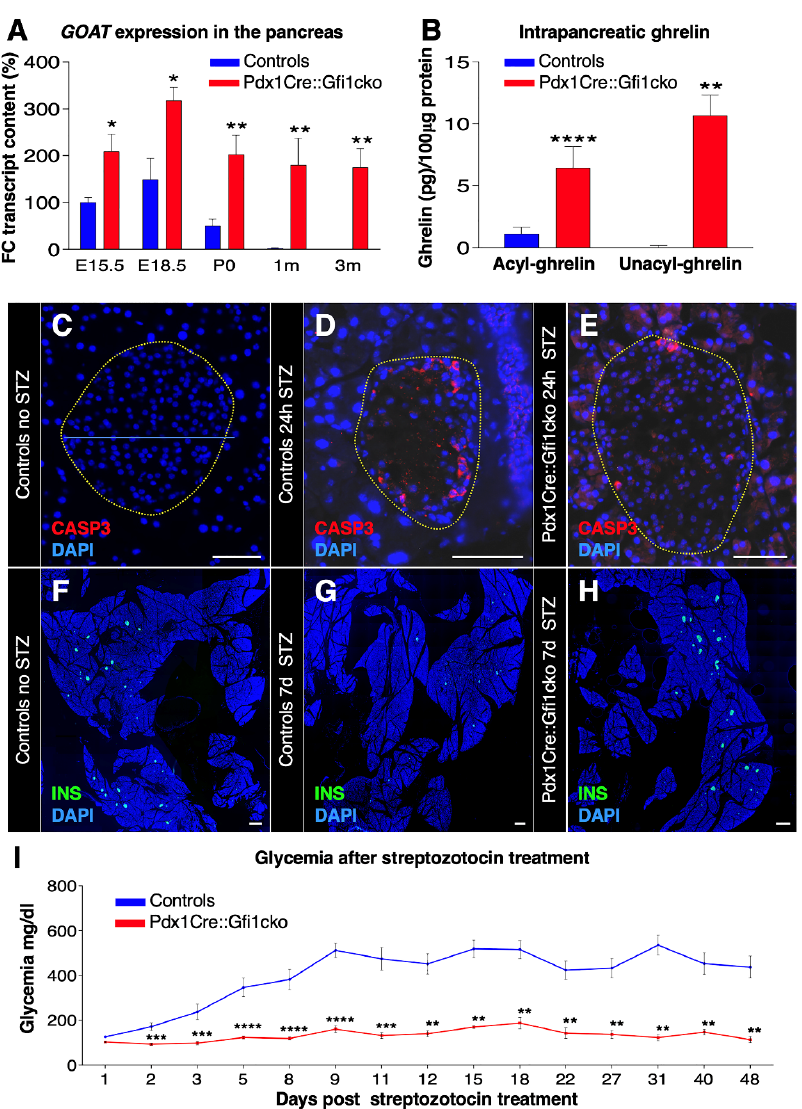
Figure 7. Pdx1Cre::Gfi1cko mice are protected against chemically-induced diabetes. The expression levels of goat were assessed by RT-qPCR in Gfi1 mutant and control pancreatic samples during embryonic development and postnatally ( n = 5 animals per genotype per (st) age) (* p < 0.05, ** p < 0.01) ( A ). ELISA immunodetection of acyl- and deacyl-ghrelin was performed on protein lysates from whole pancreatic tissue extracted from control and Gfi1 mutant mice. ( n = 6 animals per genotype) (** p < 0.01, **** p < 0.0001) ( B ). Immunohistochemical evaluation of pancreatic islets of Langerhans targeting active caspase-3 (in red) of control and Gfi1 mutant mice 24 h after treatment with or without high doses of STZ. Objective magnification: 20×. Scale bar: 50 μ m ( C – E ). Immunohistochemical assessment of β -cell mass was performed on sections isolated from control and Pdx1Cre::Gficko mice following 7 days of STZ treatment ( F , H ) and non-treated controls ( G ). Objective magnification: 10×. Scale bar: 500 μ m. Basal glycemia of STZ-treated control and Gfi1 - deficient mice for 7 weeks. ( n = 8 animals per genotype) (** p < 0.01, *** p < 0.001, **** p < 0.0001) ( I ). Physiologically, ghrelin is a potent orexigenic hormone [30]. However, the assessment of average daily food intake and body weight of adult mice, fed with either chow or HFCD, did not show any significant difference between Pdx1Cre::Gfi1cko and control mice (Figure S5A–D). Importantly, when blood levels of either acyl- or deacyl- ghrelin were assessed by ELISA immunoassay, we failed to detect any significant difference between control and Gfi1 -deficient samples (Figure S5E,F). Altogether, these data suggest that the ghrelin synthetized by pancreatic acinar cells of Gfi1 mutant mice is not secreted in the general circulation and, therefore, does not affect feeding behavior. Beside stimulating food intake, ghrelin was proposed to promote pancreatic β -cells survival in vitro [6,31,32]. We therefore wondered whether a strong increase in intrapancreatic ghrelin, such as the one observed in Pdx1Cre::Gfi1cko mice, might protect β -cells against apoptosis. To verify this hypothesis, we induced β -cell apoptosis by